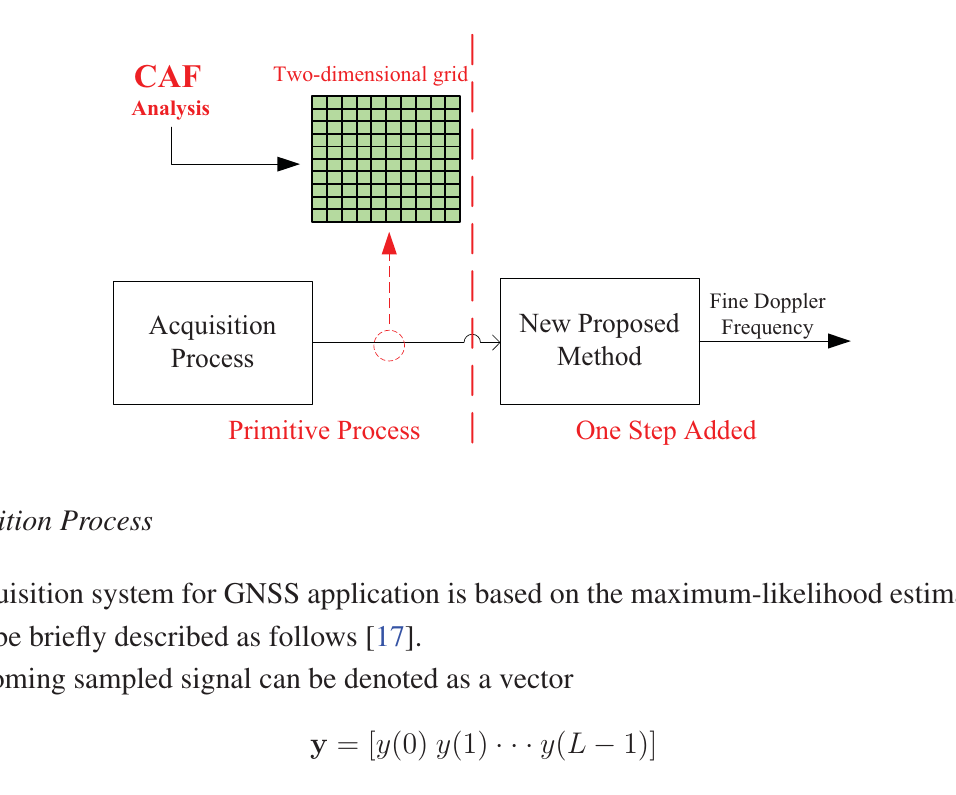
Figure 1. Brief structure of new Doppler frequency refinement